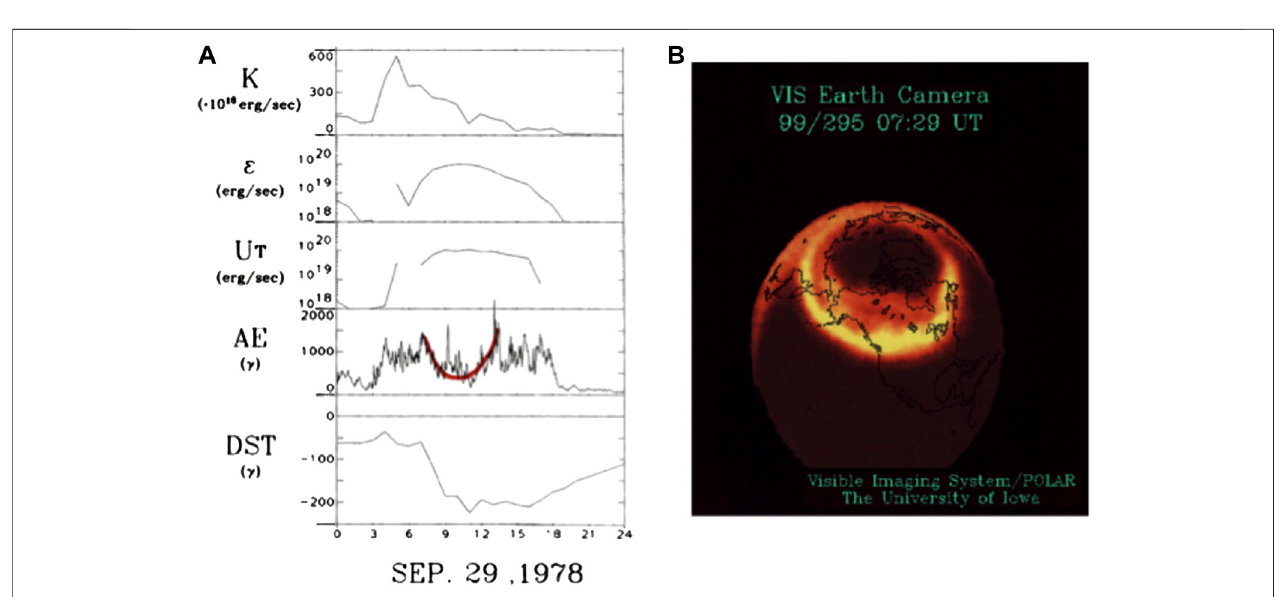
FIGURE 19 | (A) It shows from the top, the kinetic energy fl ux of the solar wind, the power, the total energy dissipation (Ut) and the AE and Dst induces. Note that during themiddleofthemainphase,theAEindexdecreased. (B) Anexample oftheexpandedauroralovalduringintensegeomagneticstorms; notethat (A) and (B) are not the same event.